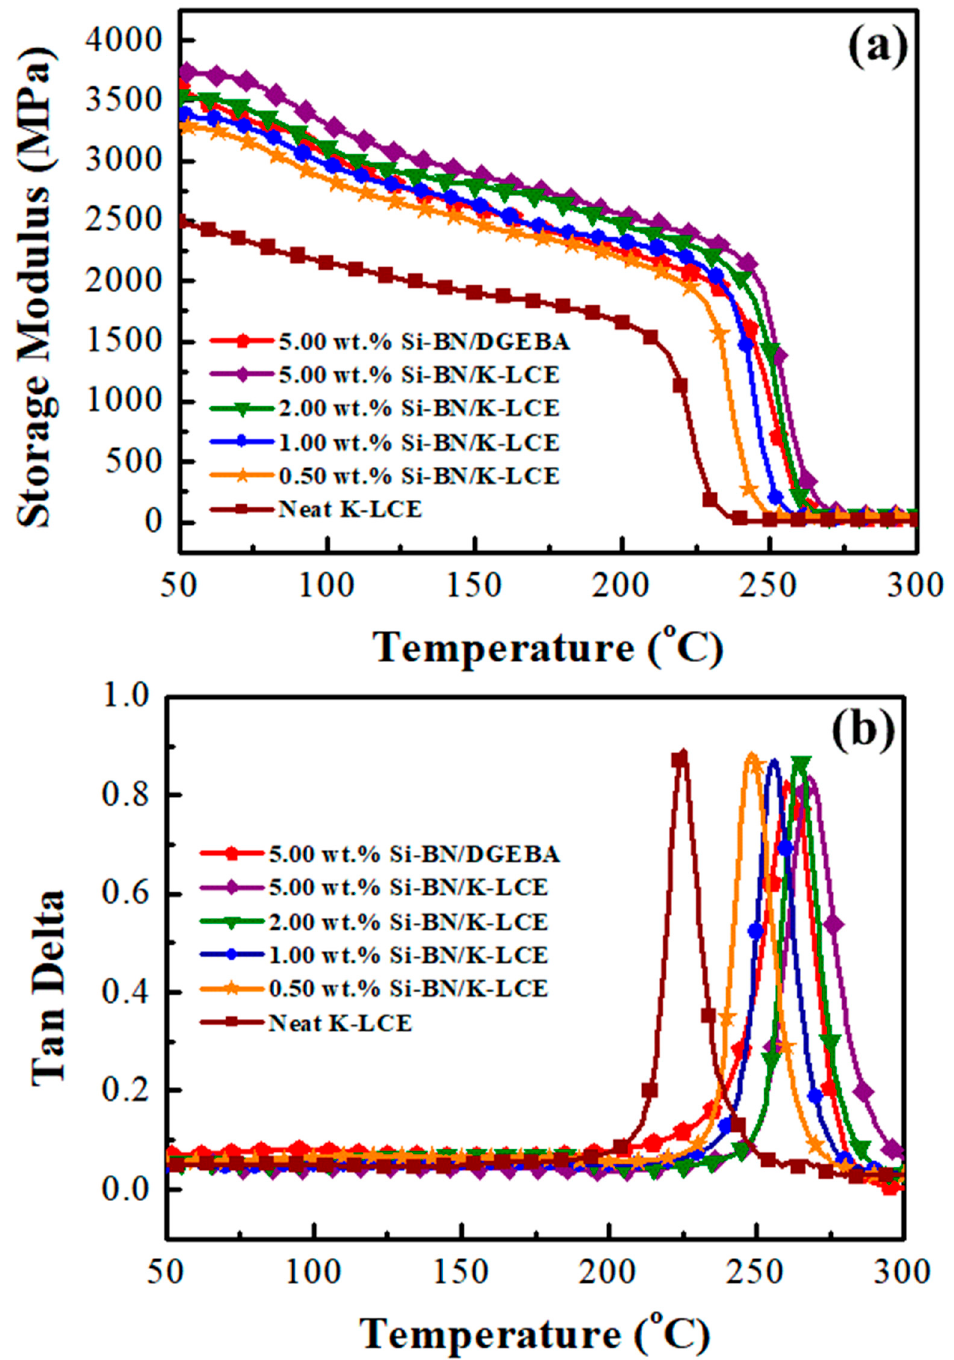
Figure 5. DMA curves of neat K–LCE and K–LCE/BN composites ( a ) storage modulus ( b ) tan delta.